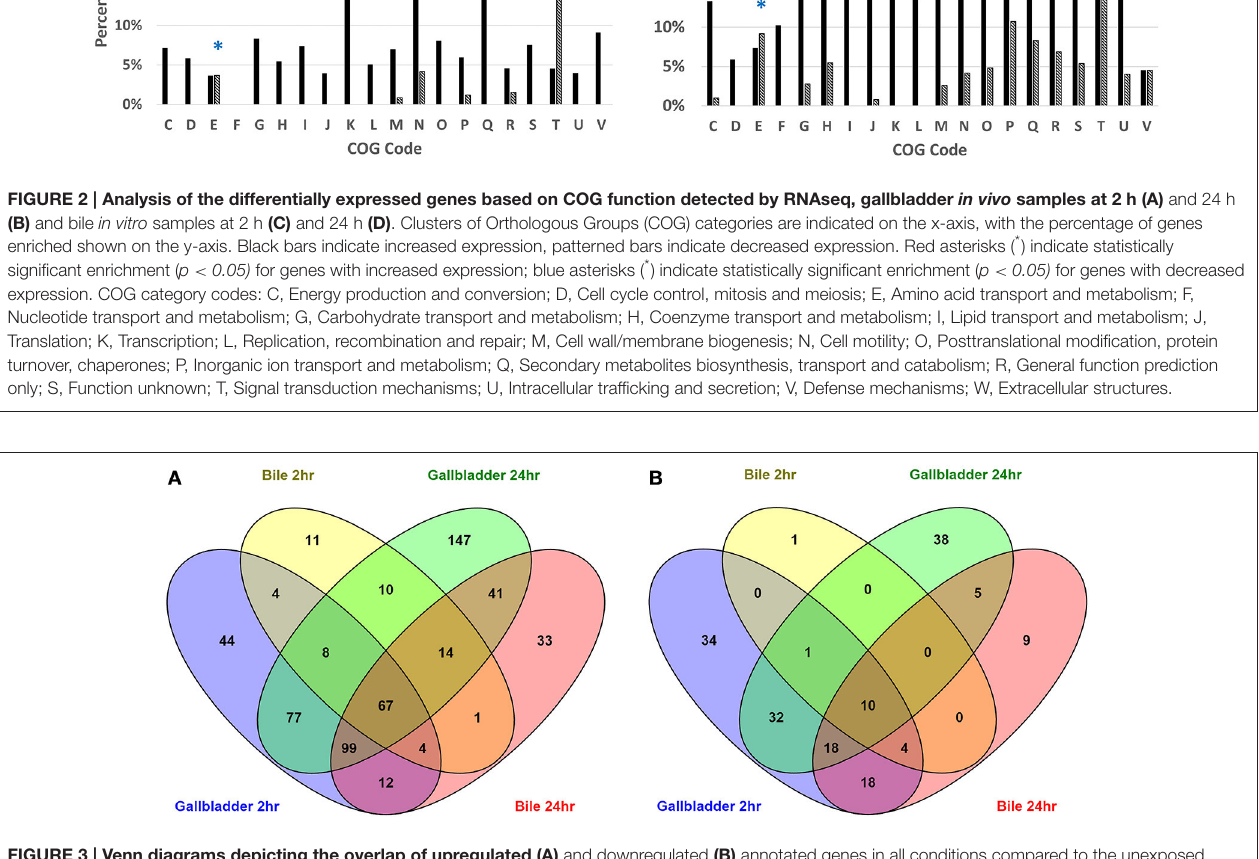
in other genera of bacteria. Assessment for conserved structural protein domains was performed using NCBI Protein BLAST and in this case did yield a prediction of conserved structure